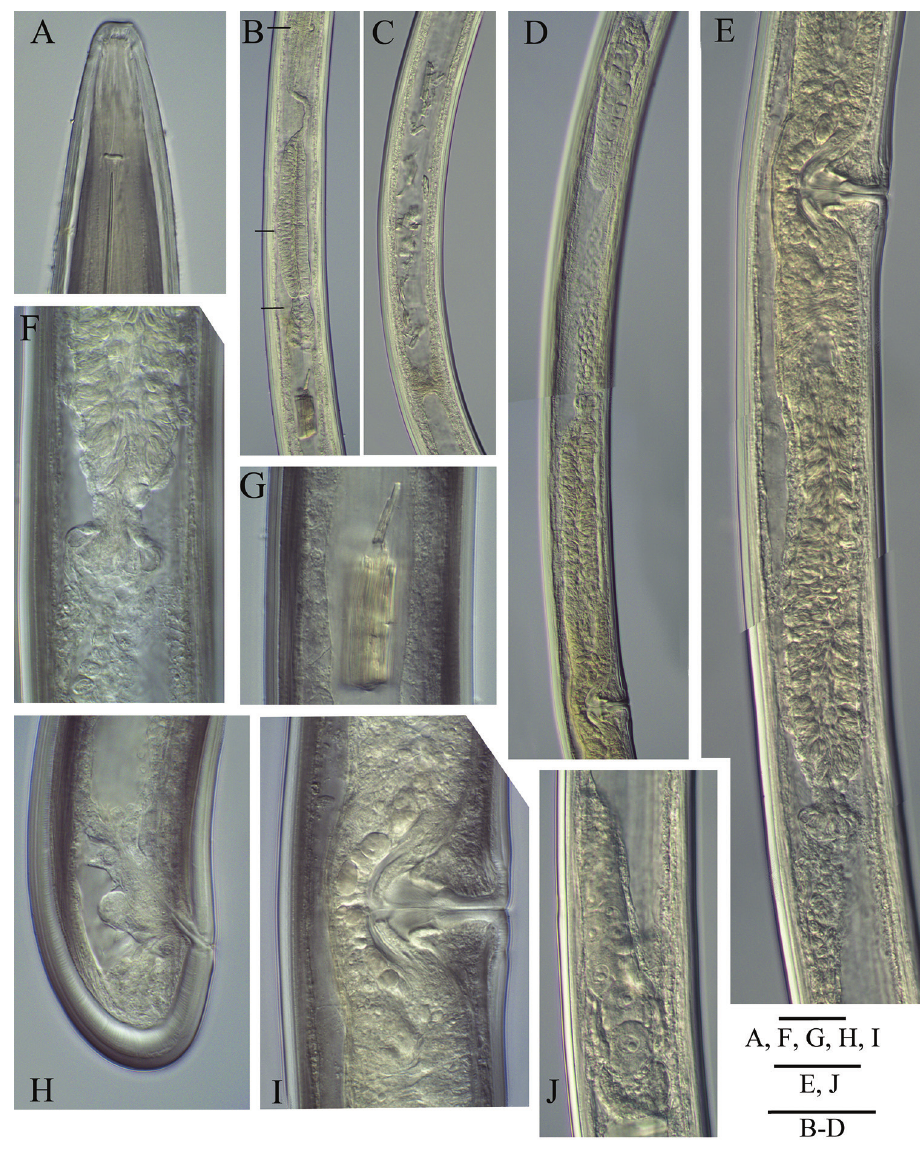
Figure 3. Longidorus polyae sp. n., holotype A anterior end B pharyngeal region, arrows point to at nerve ring, pharyngeal bulb and cardia C intestine, posterior part with inclusions D anterior genital branch E vagina and part of the posterior genital branch F sphincter G intestine inclusion at higher magnification H tail I vagina J posterior ovary. Scale bars: 20 μm ( A, F–I ); 40 μm ( E, J ); 100 μm ( B–D